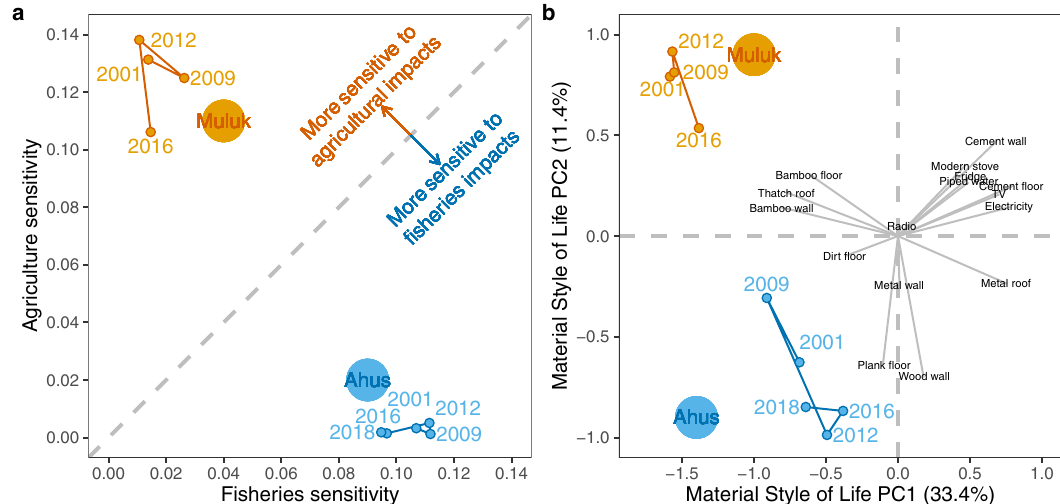
Fig. 5 Changes in (a) agriculture- fi sheries sensitivity and (b) material wealth over time in two Papua New Guinean communities: Muluk (orange) and Ahus (blue). b shows how the communities change along the fi rst two axes of a principal component analysis (i.e., PC1 and PC2), based on 16 household- scale material items, with black text and grey lines indicate the relative contribution of each material item to principal